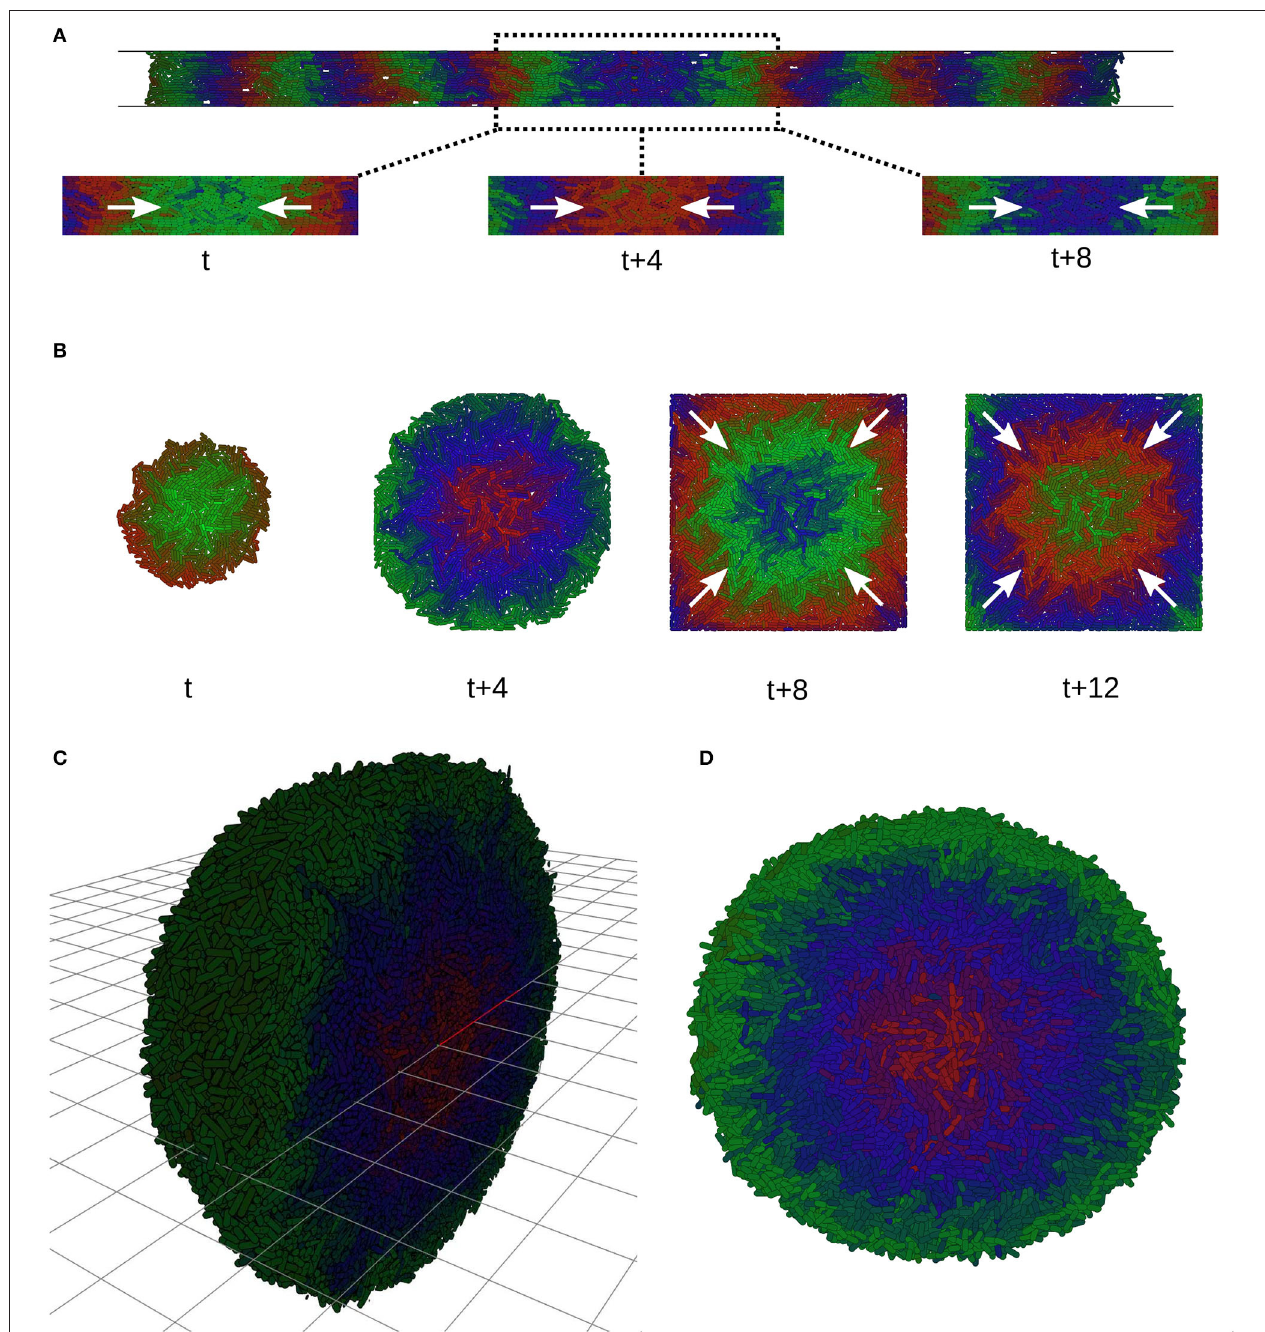
FIGURE 9 | Traveling waves in microfluidic devices. (A) Simulations of a monolayer of cells in a narrow infinite channel 20 cell diameters wide and one cell diameter tall. Traveling waves start at the sides and merge in the center (white arrows). (B) Growing colony in a square simulated microfluidic chamber. Before the colony reaches the constraints it grows with radial symmetry and initiates traveling waves (t, t+4). At t+12 the colony has used all the space and is constrained by chamber, growth arrest occurs, but the traveling waves continue (white arrows). (C) Spherical colonies grow when not constrained to a plane, forming traveling layers of gene expression. Image shows a cutaway of half the colony. (D) Transversal section of (C)